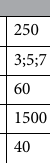
Table 2. Laser parameters used in the experiment.